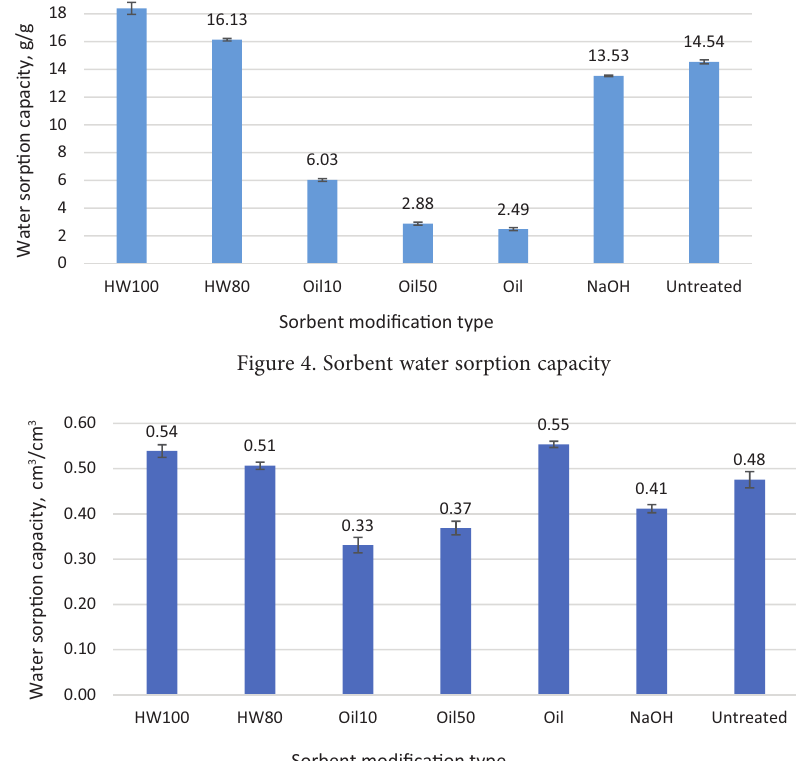
Figure 5. Water sorption capacity of